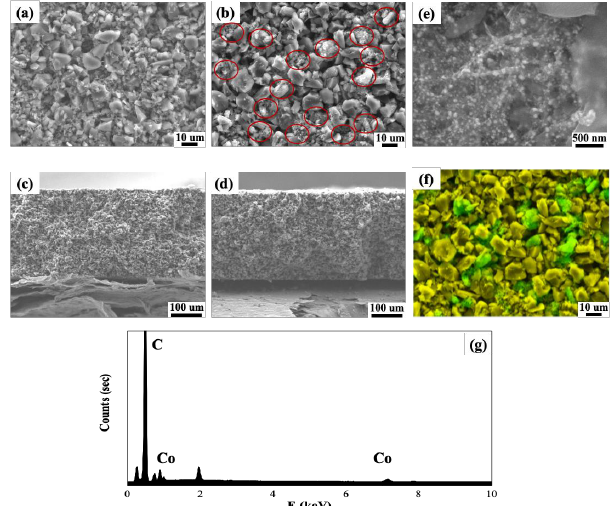
Figure 4. FE-SEM images of CDI electrodes coated onto graphite foil consisting of activated carbon (AC) only (( a ) and ( c )) and AC with ZIF-67@CNTs (( b ), ( e ), and ( d )). ( a ), ( b ), and ( e ) show top views and ( c ) and ( d ) show cross-sectional views. ( e ) High-magnification image of AC with ZIF-67@CNTs. ( f ) Corresponding EDS elemental mapping analysis of FE-SEM image ( b ). ( g ) EDS spectrum of AC with ZIF-67@CNTs electrode.